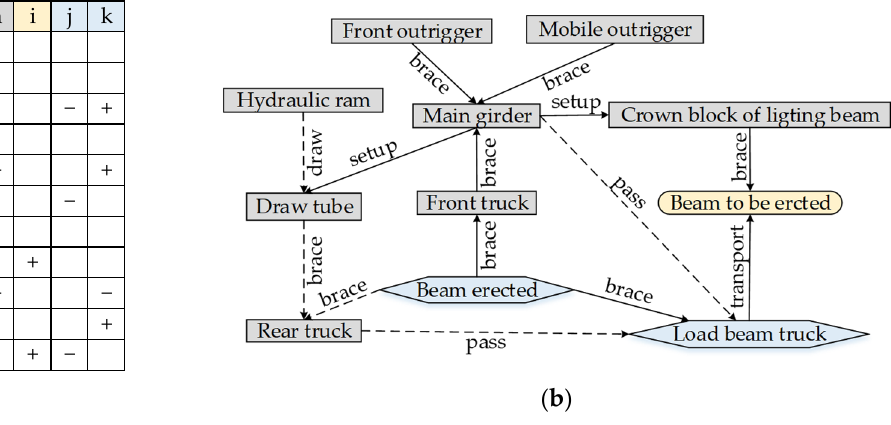
Figure 23. ( a ) Interaction matrix of system components, products, and super-system components for the preliminary solution; ( b ) Function model of the preliminary solution.